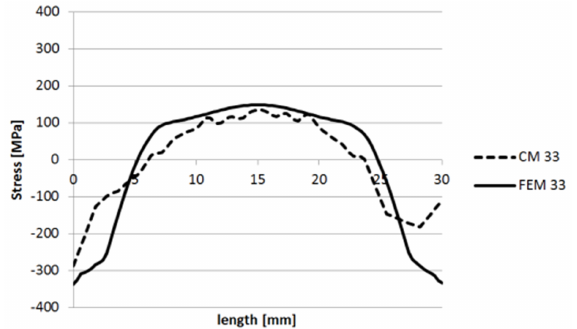
Figure 51. Stress levels in 33 direction along the CD line segment.